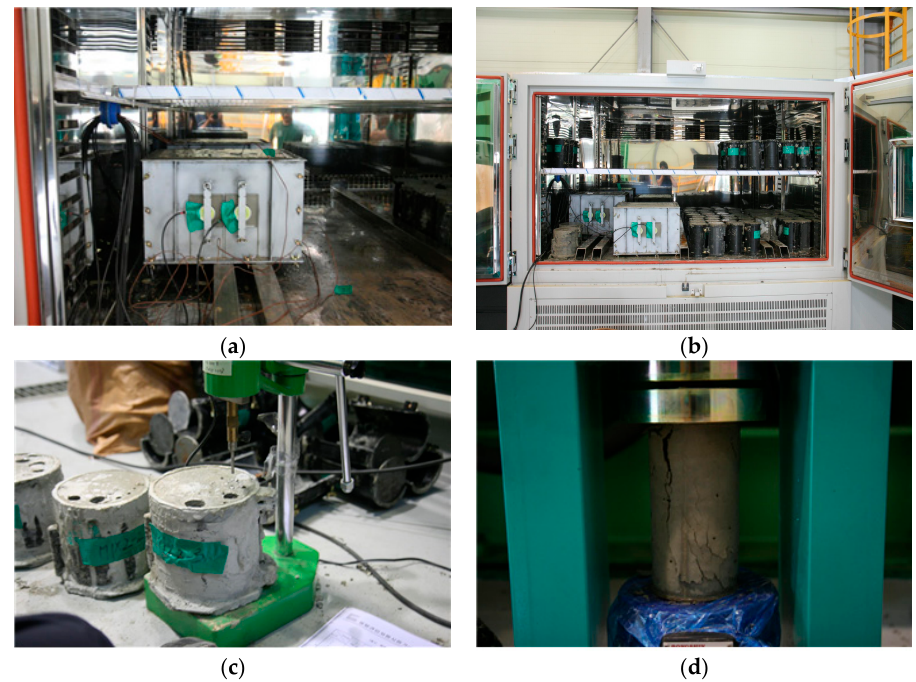
Figure 7. Experiments for in situ concrete at an early age: ( a ) specimen for the surface wave velocity measurement, ( b ) specimen in an isothermal control machine, ( c ) specimen for the penetration resistance test, and ( d ) specimen for the cylindrical compressive strength test.